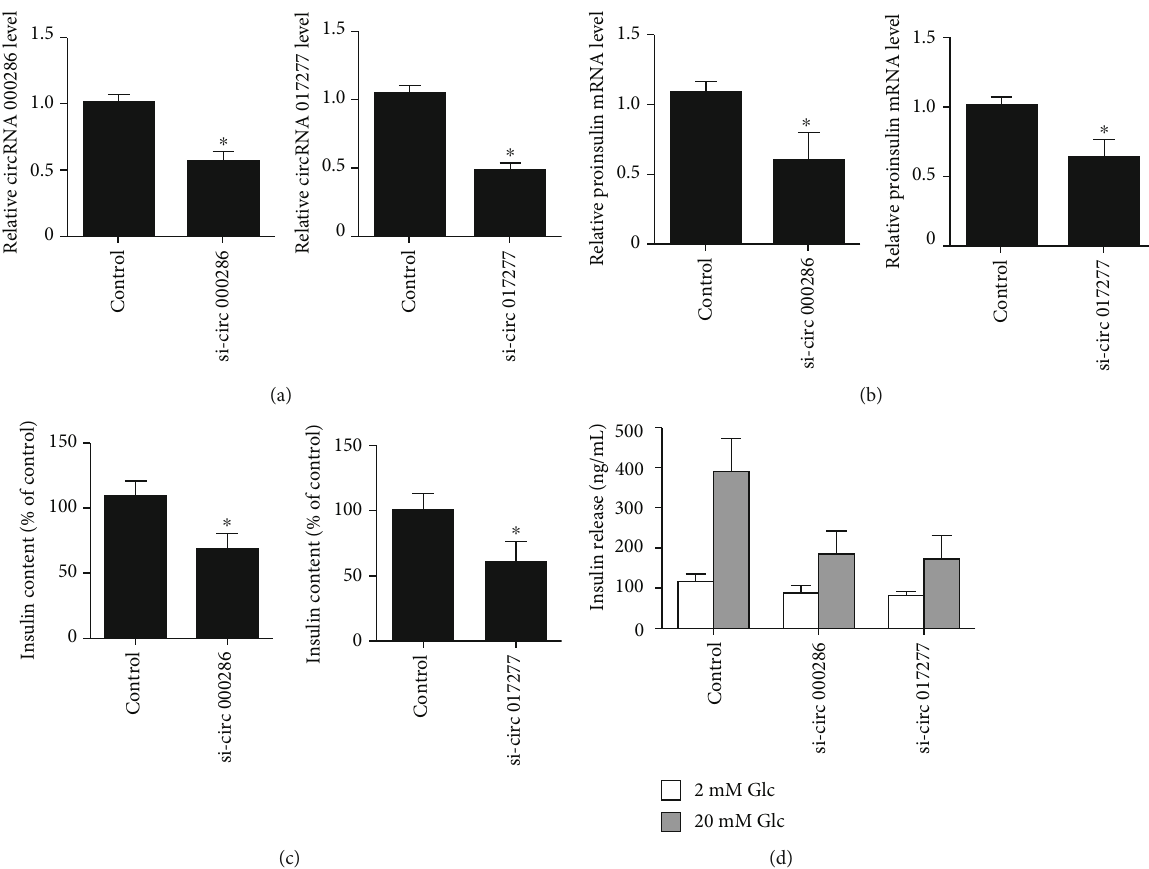
Figure 3: E ff ect of circRNAs 000286 and 017277 on insulin biosynthesis and secretion in MIN6 cells. (a) The MIN6 cells were transfected with circRNA 000286 or 017277 siRNAs. The total RNA was extracted, and the expression levels of circRNA 000286 (left panel) or circRNA 017277 (right panel) were determined to evaluate the e ffi ciency of transfection. The results are mean ± SD of three independent experiments. (b) The MIN6 were transfected with circRNA 000286 (left panel) or circRNA 017277 (right panel) siRNAs or negative control. Proinsulin mRNA levels were measured 36h later by qRT-PCR, and the results are expressed normalized to GAPDH. (c) The MIN6 were transfected with circRNA 000286 (left panel) or circRNA 017277 (right panel) or negative control. Insulin content was assessed by ELISA, and the results are expressed as percent of the values in control cells. The data shown are the mean ± SD of three independent experiments. (d) The MIN6 were transfected with circRNA 000286 or 017277 siRNAs or negative control. Two days later, the cells were incubated in the presence of 2 or 20 mmol/L glucose (Glc) for 45min. The amount of insulin secreted during the incubation period was assessed by ELISA assays. The data shown are the mean ± SD of three independent experiments. ∗ P < 0 : 05 , compared with respective